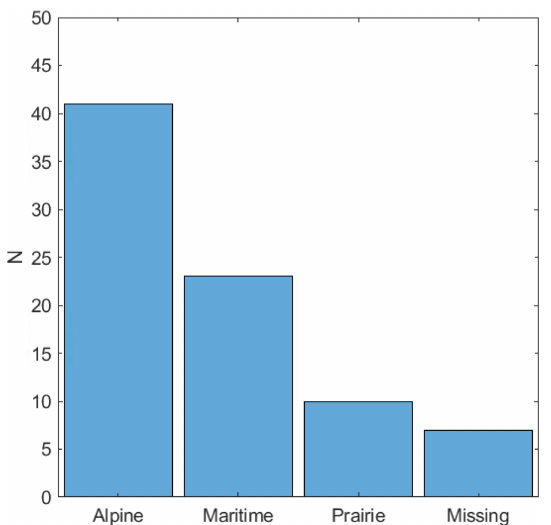
Figure 4. Snow climate classes for 81 AKAH stations.